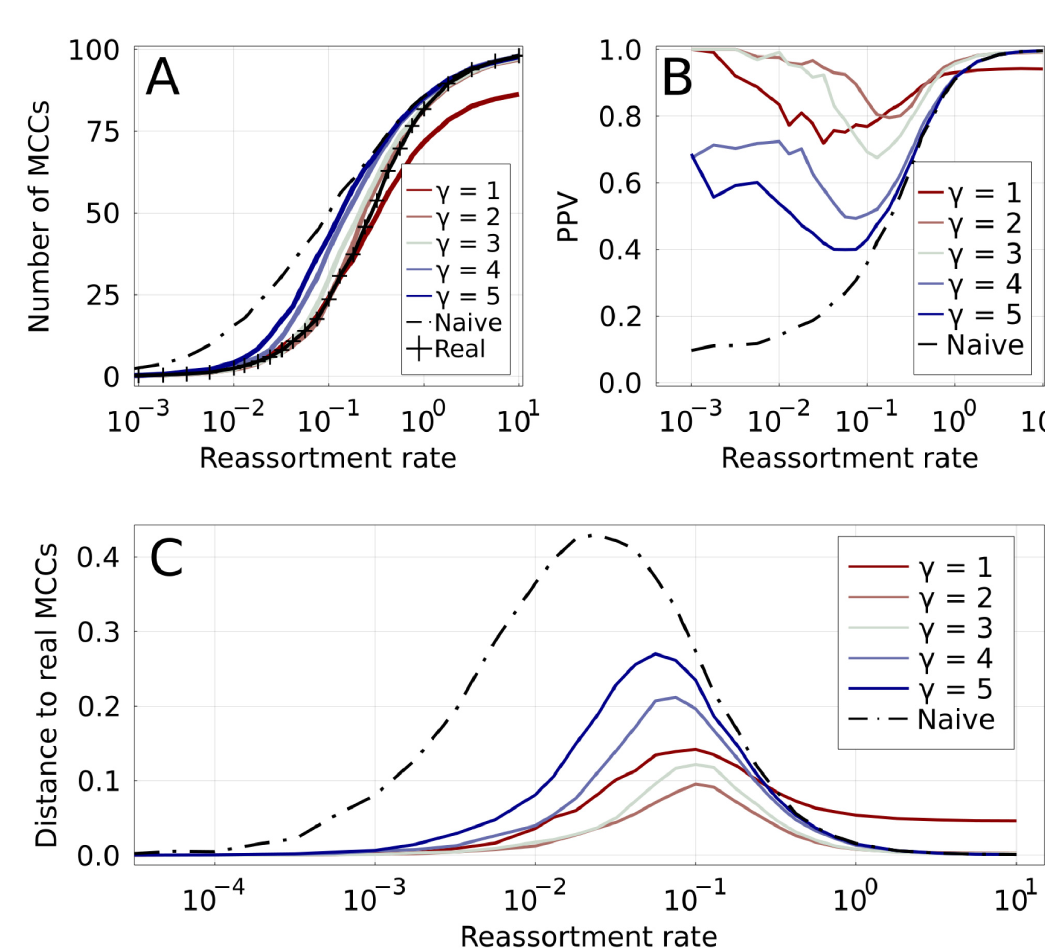
Fig 3. Accuracy of inferred MCCs in simulated ARGs. Increasing values of γ are shown by colored lines, from red to blue. A : Number of MCCs found by different methods as a function of the reassortment rate. The real number of MCCs is represented by the marked black line. The naive method (dashed black line) overestimates the number of MCCs for low r ? , while the parsimonious one ( γ = 1) underestimates it for high r ? . B : Positive predictive value for reassortments: fraction of inferred reassortments that are indeed present in the real ARG. The low number of reassortments results in a relatively large uncertainty for this quantity for r ? � 1. C : Distance between inferred and real MCCs for different methods. The distance is based on the variation of information [20].